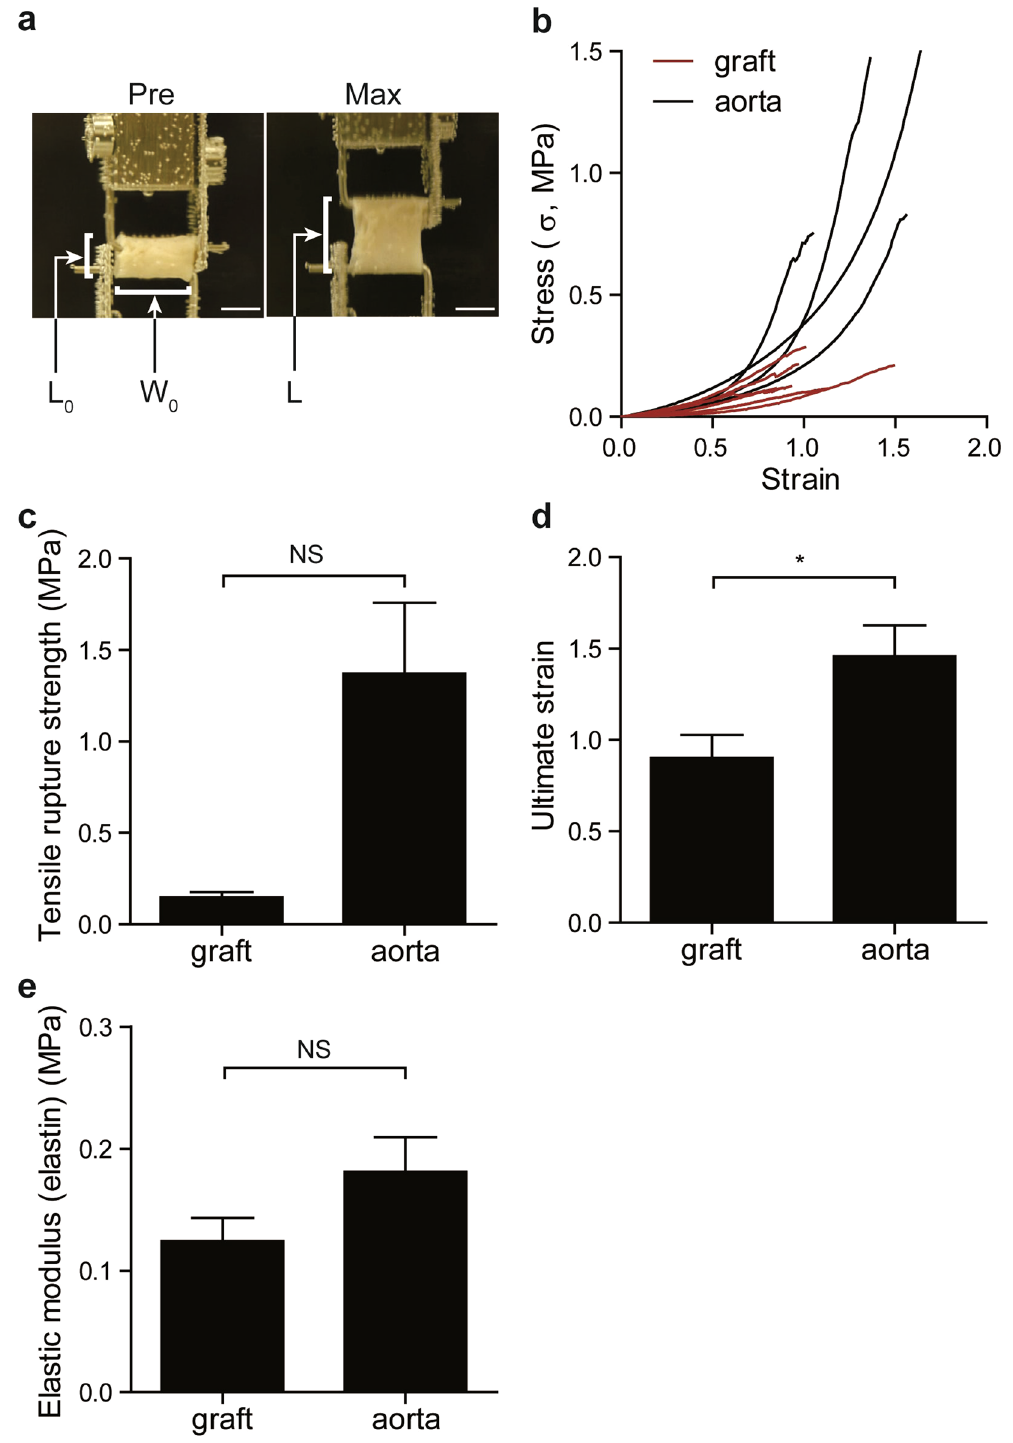
Figure 7. Mechanical properties of the tubular grafts. ( a ) Representative images of mechanical testing of tubular medial grafts. A tubular graft was placed around two parallel hooks made of stainless steel wire. A graft before pulling (Pre) and a maximum stretched tubular graft (Max). W 0 and L 0 indicate initial width of sample and sample length, respectively. L indicates sample length during the pulling. Scale bars: 3 mm. ( b ) Stress-strain behaviors of the tubular grafts and the tunica media of the adult rat thoracic aortae. ( c – e ) Comparison of tensile rupture strength, ultimate strain, and elastic modulus in elastin region between the tubular grafts and the aortae. Values are shown as the mean ± standard error of the mean (SEM) of independent experiments. Data were analyzed using two-tailed unpaired Student’s t -test with ( c ) or without ( d and e ) Welch’s correction. n = 4 and 8 (rat aorta and grafts, respectively); NS, not significant; * p <